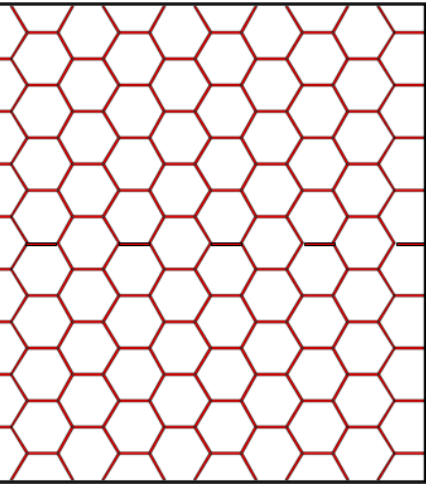
Figure 6: 2D model of a polycrystal (CZM interface elements are shown in red with a suitably amplified thickness, for visual